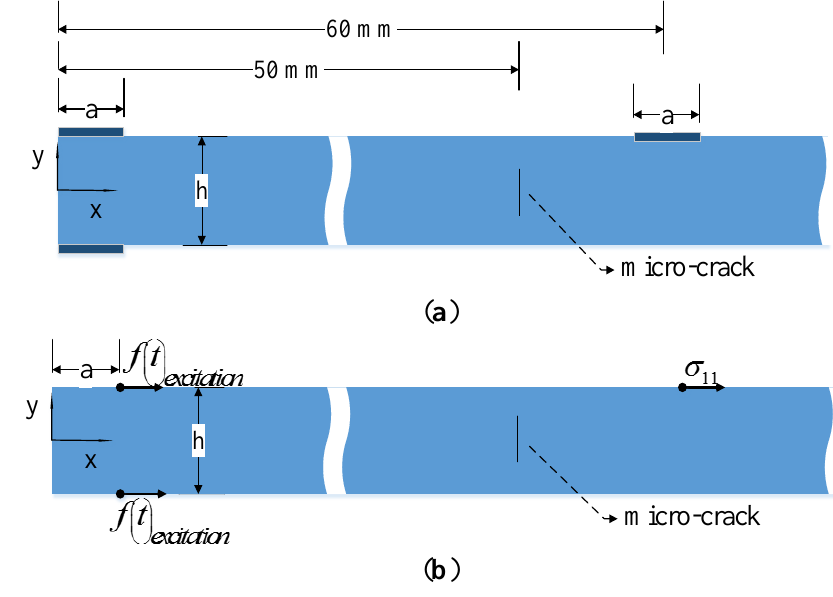
Figure 2. ( a ) Geometry of the plate for simulations and PZT wafer’s configuration. ( b ) Point force model for